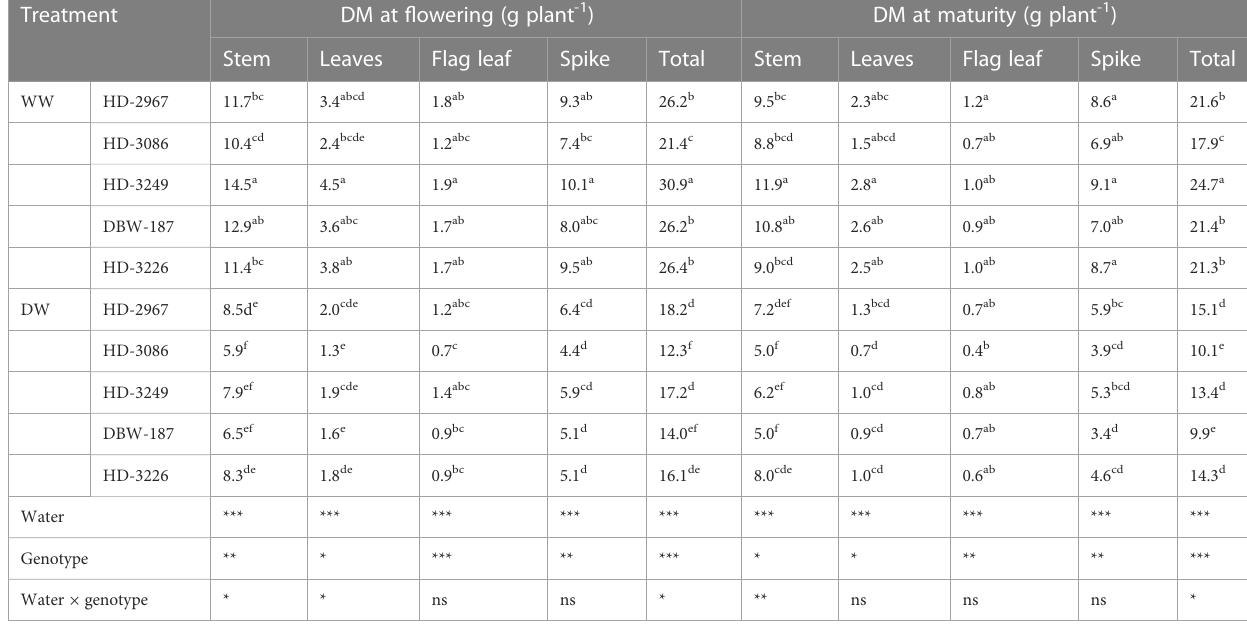
TABLE 2 Shoot biomass of vegetative organs at fl owering (Z 61 ) and maturity (Z 89 ) of wheat genotypes grown under well- and de fi cit-watered conditions. Treatment DM at fl owering (g plant -1 )